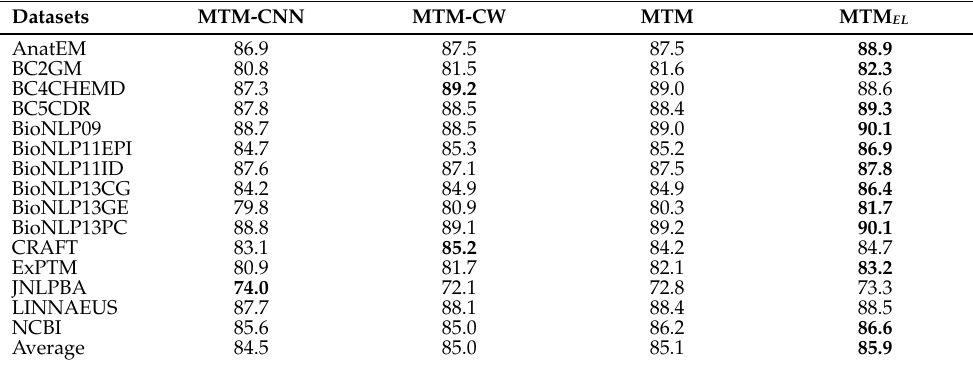
Table 9. Results comparison of ELMo with SOTA MTMs.